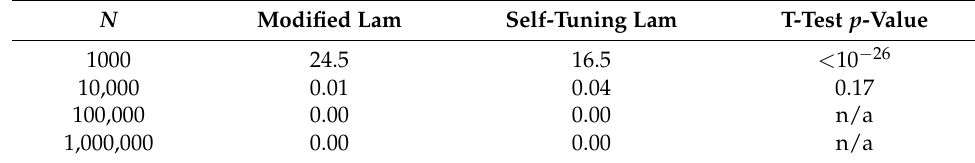
Table 2. Average solution cost for the OneMax problem, case when each 0-bit costs 1. N